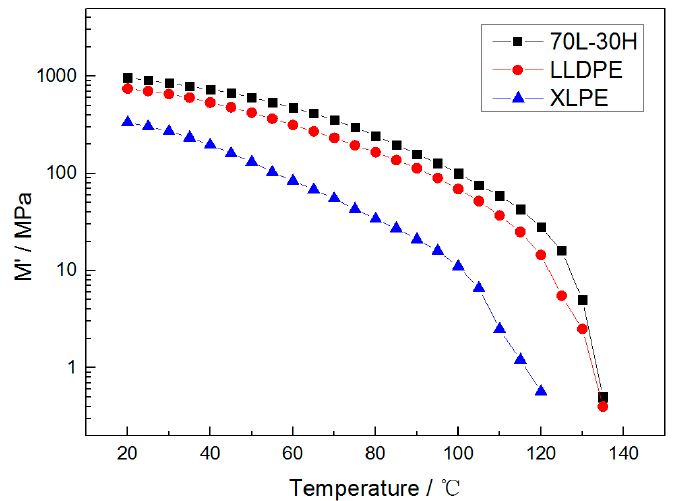
Figure 3. The temperature spectrum for dynamic thermo mechanical of 70 L-30 H, LLDPE and XLPE.